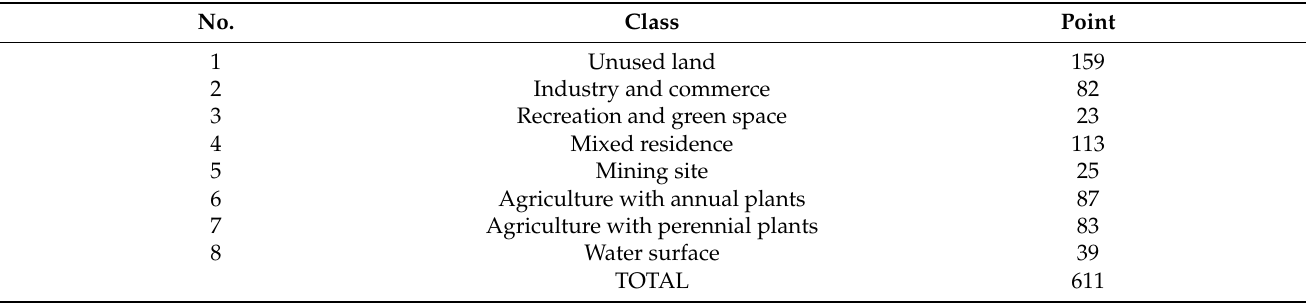
Table A4. Summary of validation data for the land use